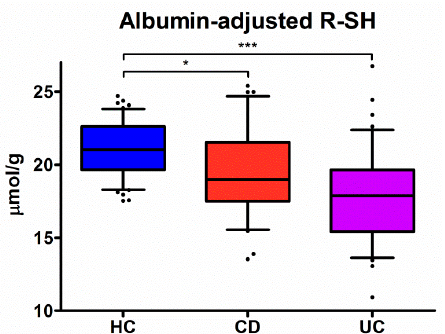
Figure 1. Albumin-adjusted serum free thiols (R-SH) ( µ mol / g) are highly significantly reduced in both Crohn’s disease (CD) and ulcerative colitis (UC) patients as compared to healthy controls (* P < 0.05 and *** P < 0.001, respectively).